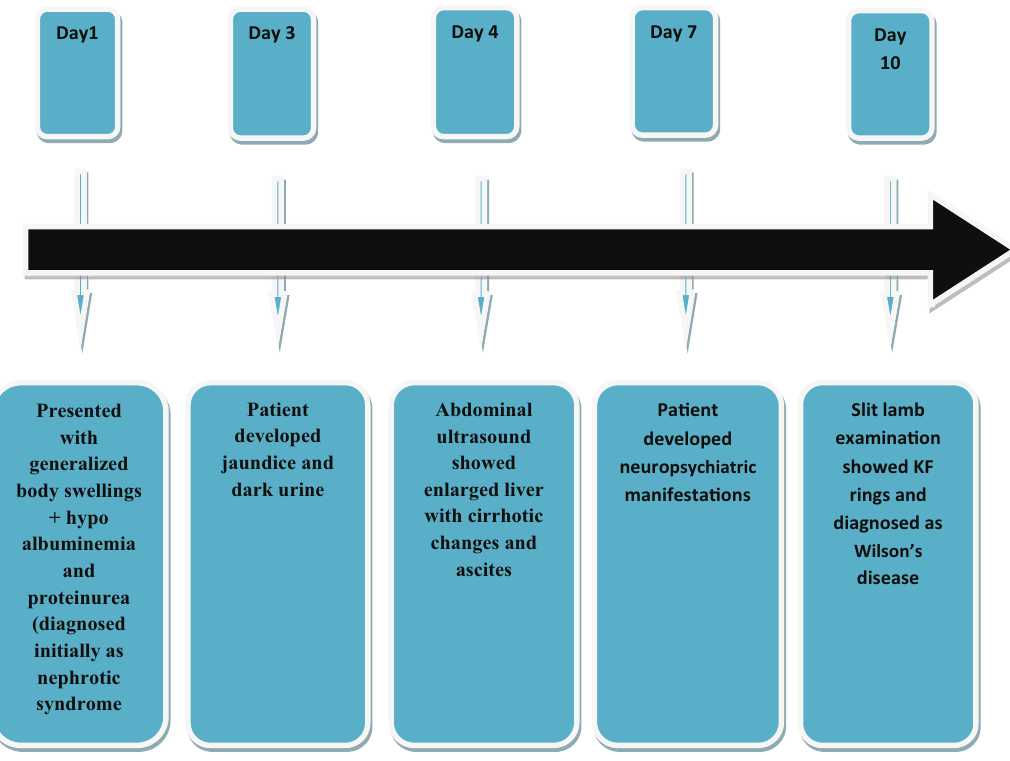
Figure 4 : Timeline describing patient’s key date in diagnosis. TABLE 1: Liver function